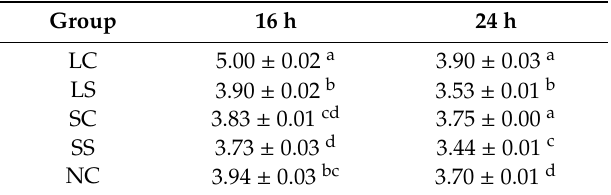
Table 2. Final pH values (mean ± SD) of the fluid in di ff erent biofilm chambers for five experimental groups 16 and 24 h after the last probiotic rinse.